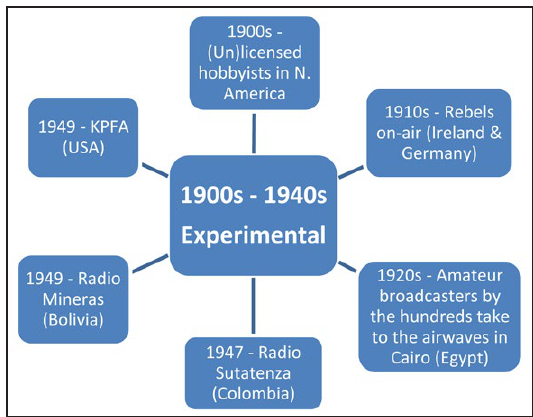
Figure 2: Experimental period of community radio